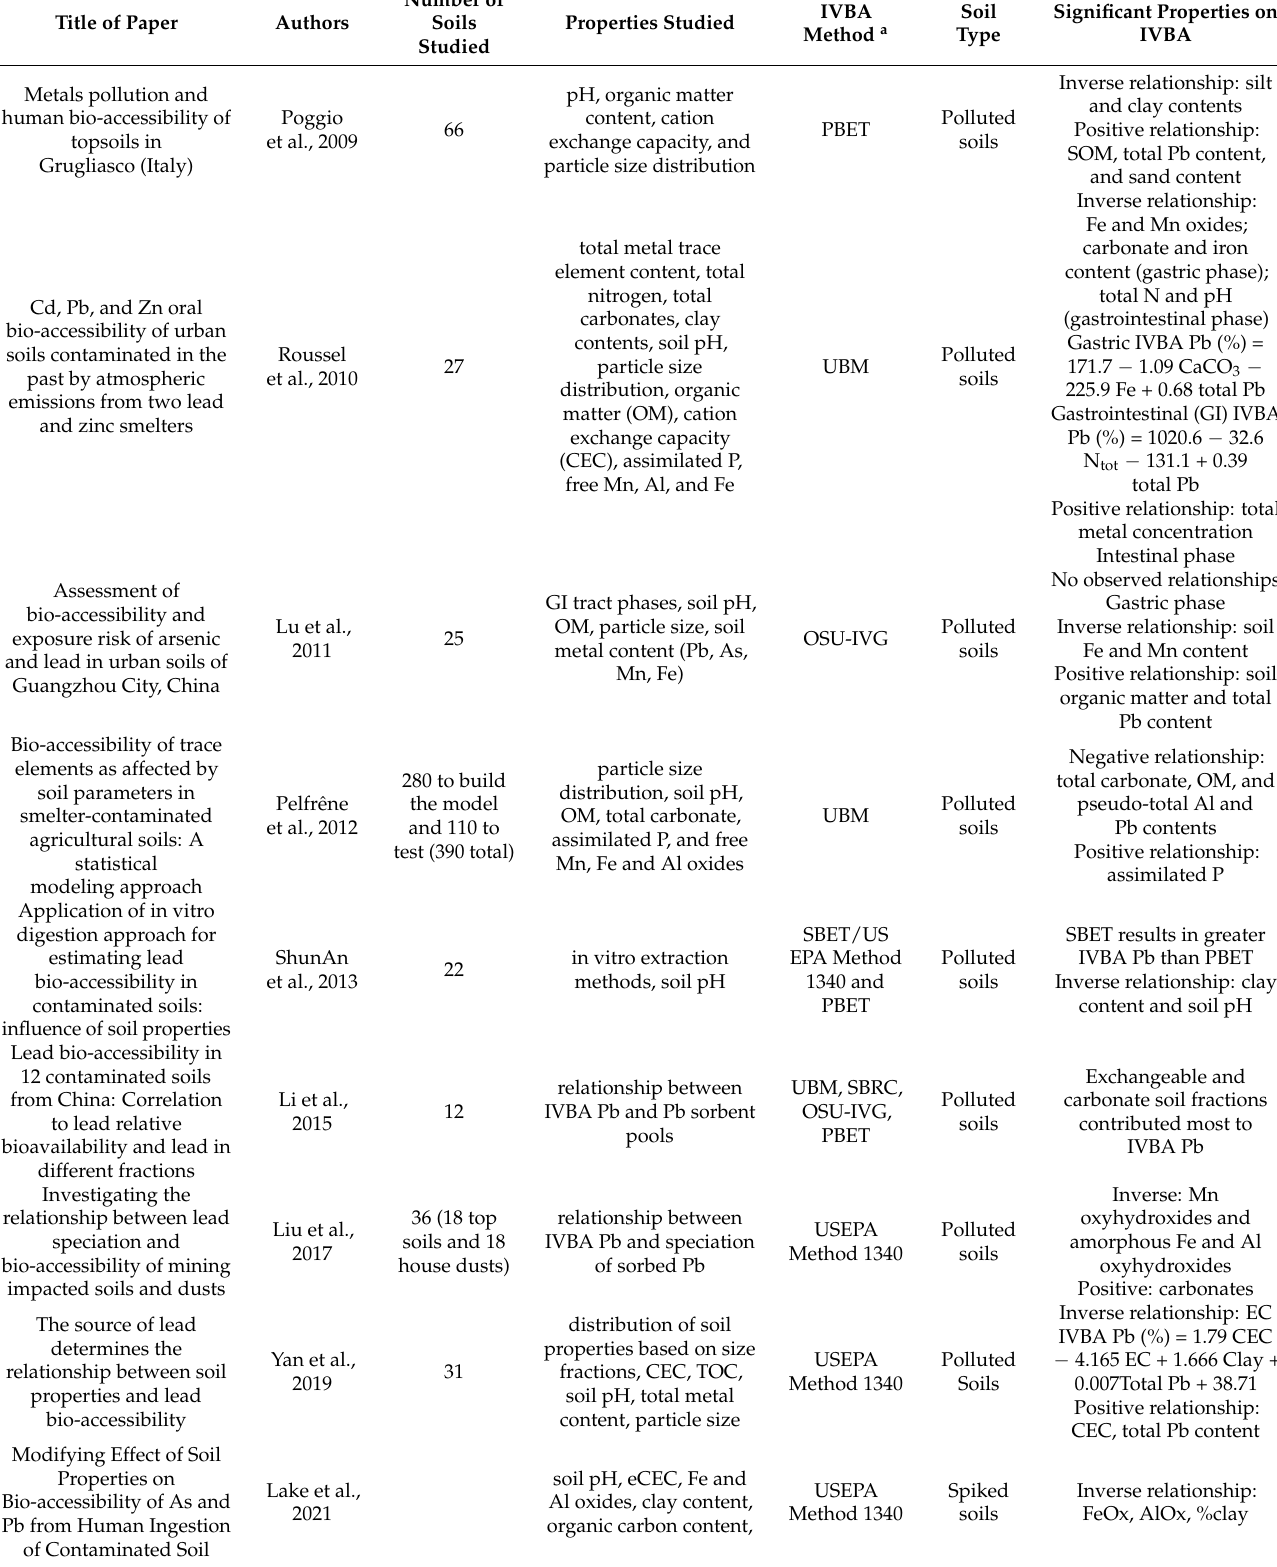
Table 2. Studies on the Effect of Soil Properties on Bio-accessible